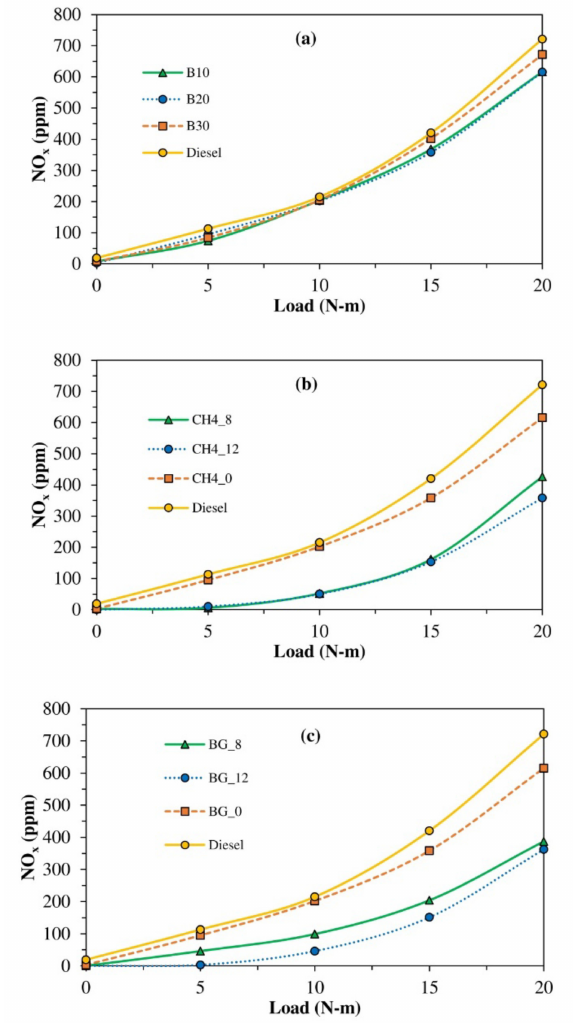
Figure 3. Variation of NO x emissions with load at various ( a ) Mahua biodiesel blend, ( b ) methane flow rate and ( c ) biogas flow